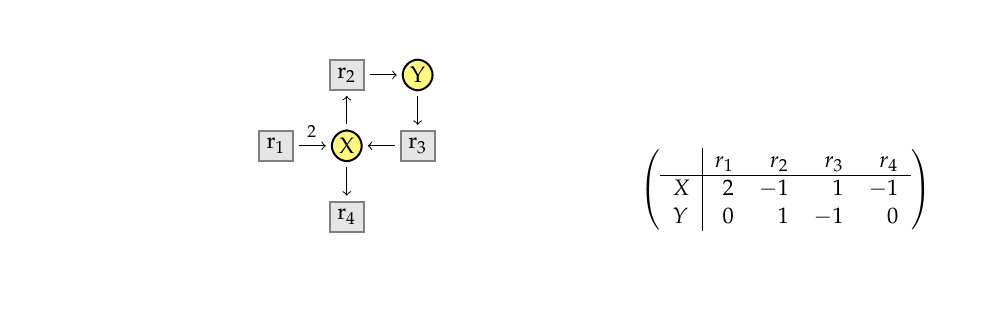
Figure 4. A reaction network and the associated graph and stoichiometry